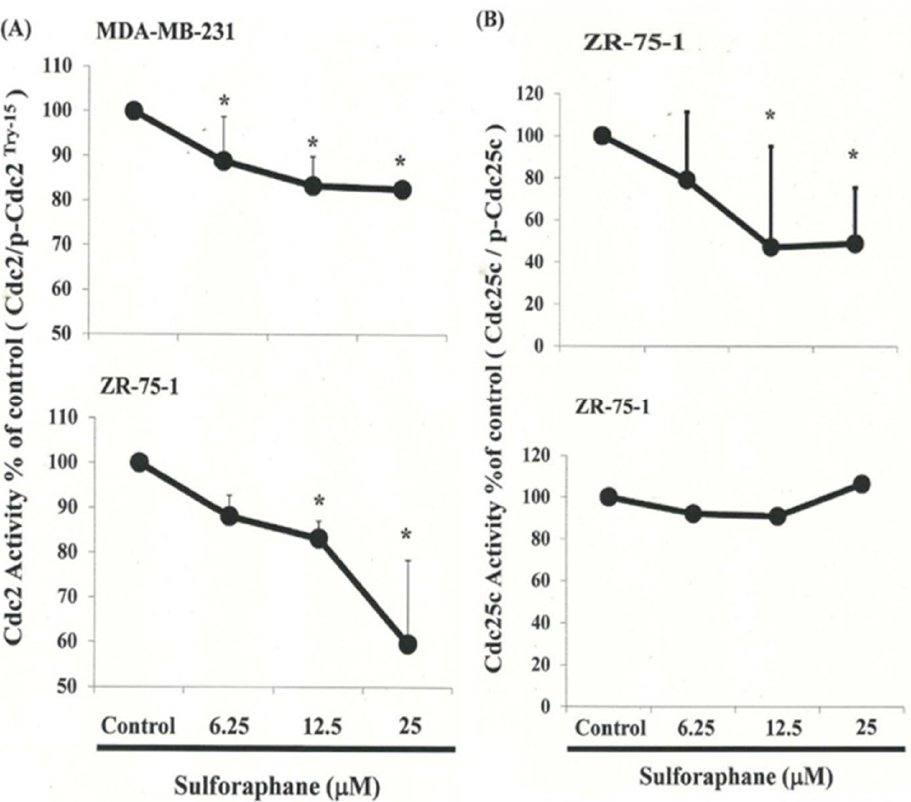
Figure 4. SFN repressed CDC2, CDC25C activity in MDA-MB-231 and ZR-75-1 cells. Cells were treated with SFN for 24 h, protein expression was subsequently detected by Western blot analysis, representative blots from three independent experiments. Quanti fi cation of band intensities. ( A ) CDC2 activity; ( B ) cdc25c activity. * in each group of bars indicates that the di ff erence resulting from treatment with 0 ìM SFN was signi fi cant at p < 0.05. All data are reported as the mean (±SEM) of at least three separate experiments.